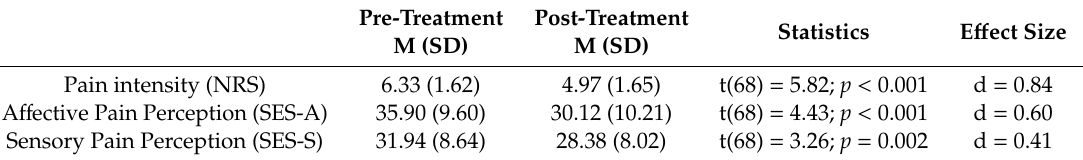
Table 3. Pre–post changes in pain outcomes. N = 69.